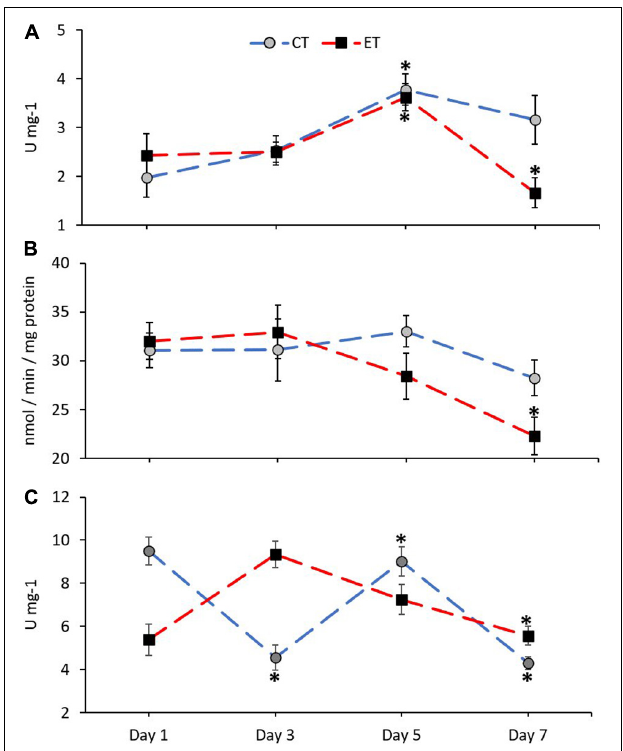
FIGURE 5 | Enzymatic activity of catalase, CAT (A) , glutathione S -transferases, GST (B) , and superoxide dismutase, SOD (C) in coral samples from CT and ET during the experimental period. All data points are mean ± SE ( n = 9). Asterisk represents a significant difference ( p < 0.05).